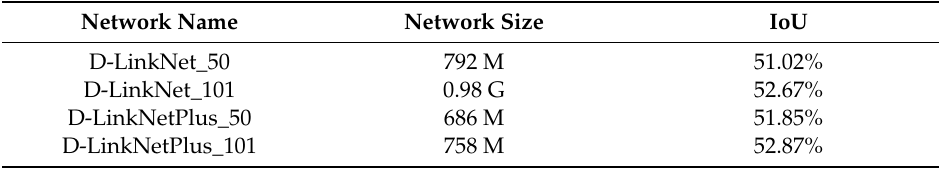
Table 2. Comparison results of network size and road precision between D-LinkNet and